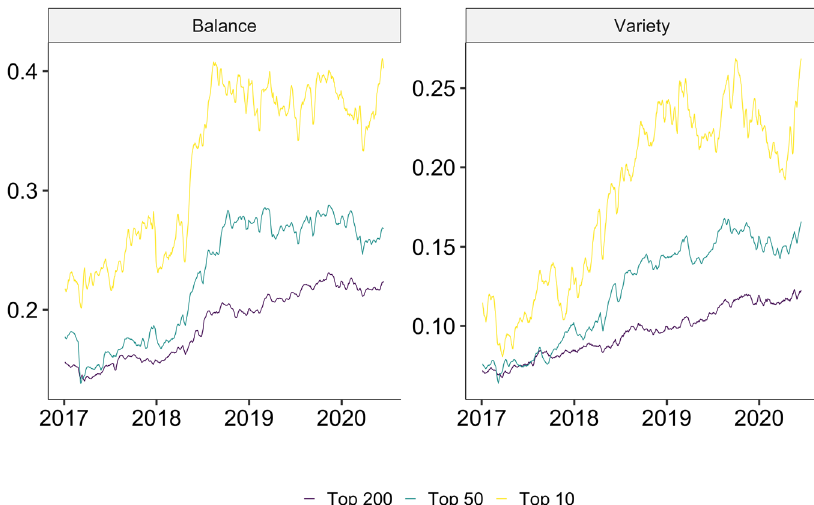
Fig. 6 Balance and variety of labels on the charts. The left panel shows the balance of labels over time for three sizes of the top chart, displaying increases over time especially for the highest positions in the chart. The right panel shows the variety of labels on the charts. The same patterns as for balance can be observed.